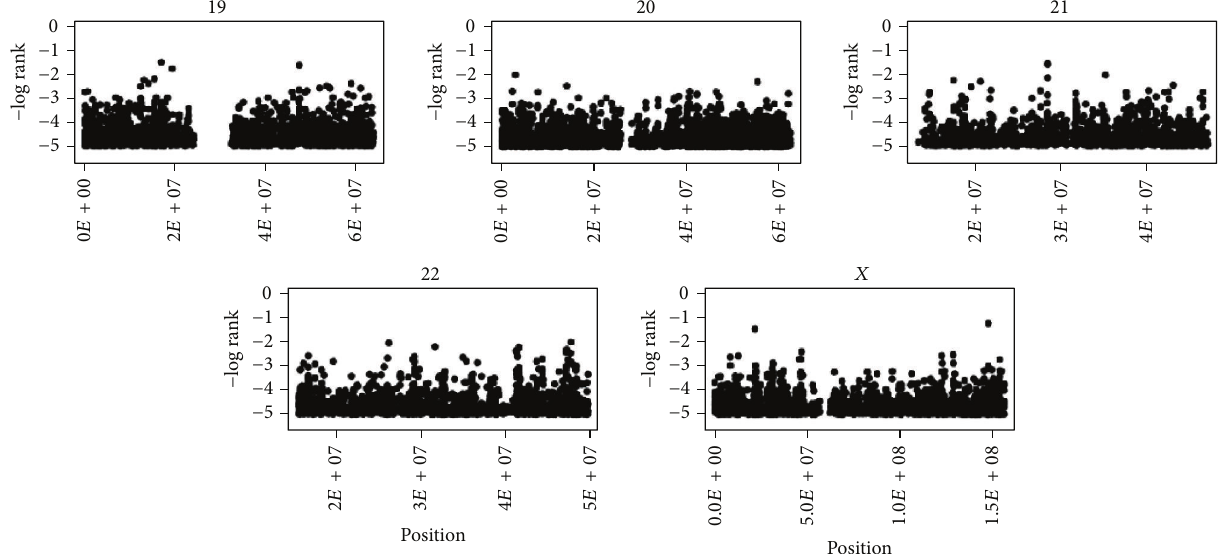
Figure 2: Genome-wide plot of the silhouette scores for the top 100,000 SNPs. The chromosome number is indicated on the top of each subgraph. The 𝑦 -axis represents the silhouette score ranking on a log scale and the 𝑥 -axis indicates the position of the SNPs in physical